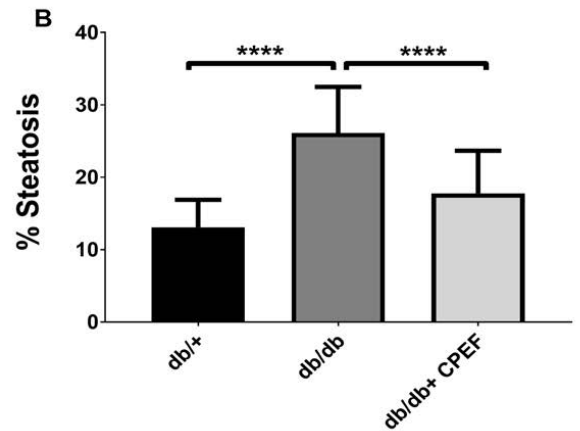
Figure 2. Histological assessment of the liver morphology and lipid accumulation using Hematoxylin and Eosin (H&E) staining. ( A ) Representative images of H&E-stained liver sections of db/+ mice, db/db mice, and db/db mice treated with CPEF. ( B ) Image J quantification of lipid content. Mice were treated with the vehicle control or CPEF (351.5 mg/kg) daily for 28 days. Data are represented as the mean ± SD ( n = 6–8). Fat accumulation is indicated by black arrows. Statistical significance between the groups is denoted as **** p < 0.0001 compared to the db/db control group. 2.3. Treatment with CPEF Increases Hepatic PPARα Expression A 2.2-fold increase in PPAR α expression was observed in the livers of CPEF-treated db/db mice compared to their untreated db/db control mice (158.60 ± 35.77% vs. 72.47 ± 38.70%, p < 0.01) (Figure 3A,B).